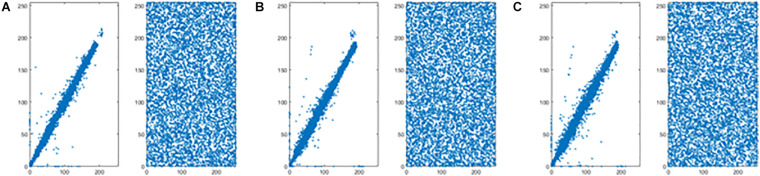
Correlation of adjacent pixels of the original image and the encrypted image for “CT-chest.” (A) Horizontal direction. (B) Vertical direction. (C) Diagonal direction.